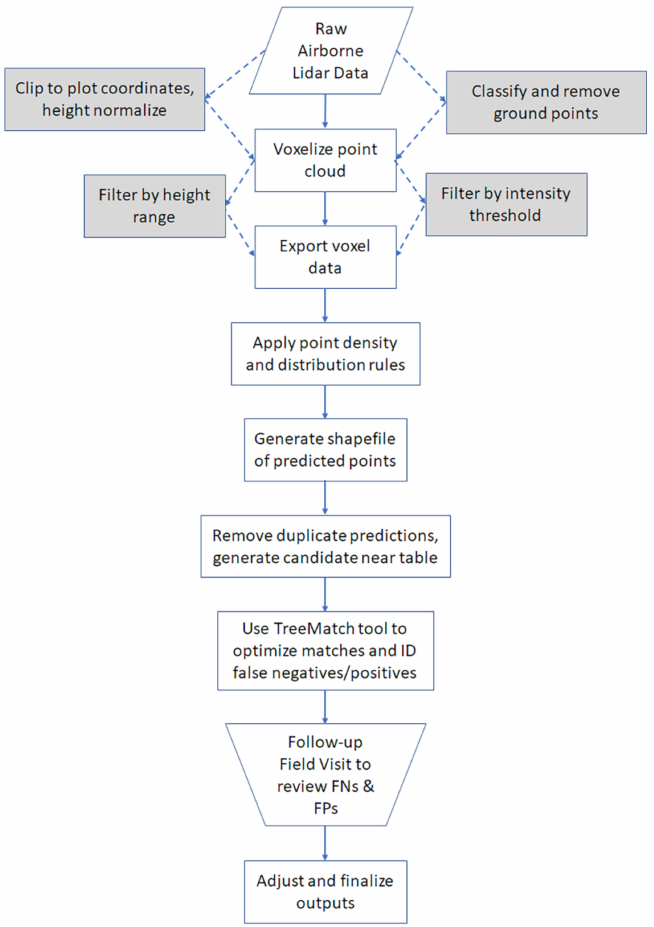
Figure 14. Flowchart of key steps of the tree detection